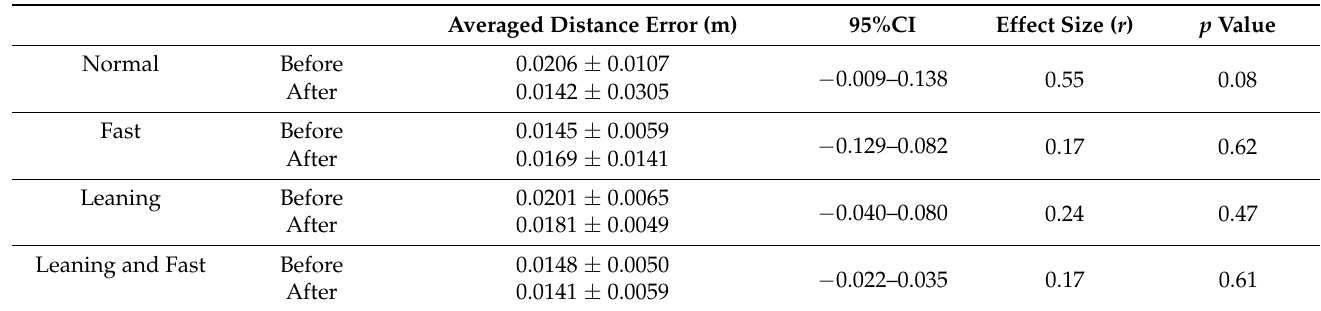
Table 5. Average distance error in the ATG for heel in lateral obstacle crossing.